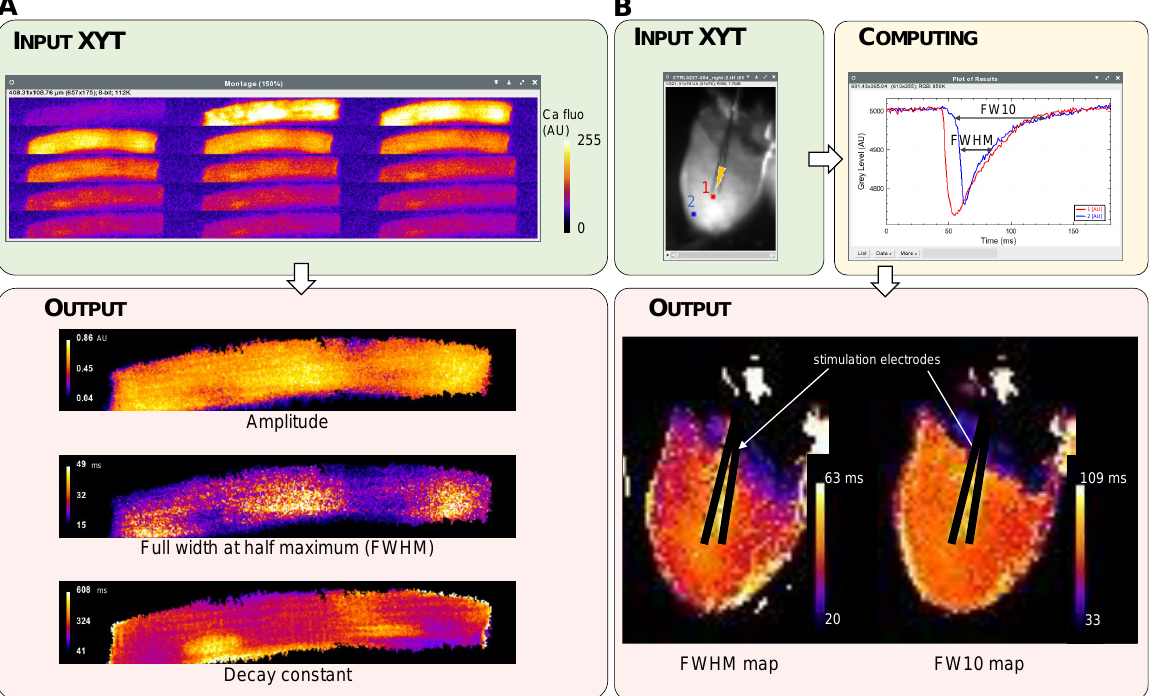
Figure 3. Examples of analysis of XYT data leading to single peak parameter maps as outputs. ( A ) Single rat cardiomyocyte evoked calcium transient recorded with confocal microscopy. The image sequence (left to right and top to bottom) shows a selection of images of the stack with a time interval of 20 ms. Output consists of three maps of relevant parameters of the calcium transient. ( B ) Propagation of an evoked action potential across a rat whole heart. Input image is an image stack obtained from an optical mapping experiment. The position of the stimulation electrodes is indicated by the lightning symbol. The two-colored points illustrate the Spiky software processing occurred for each pixel of the image. After processing, FWHM and FW10 (action potential durations at respectively 50% and 90% of repolarization) are displayed in different areas of the heart as pseudo-colored